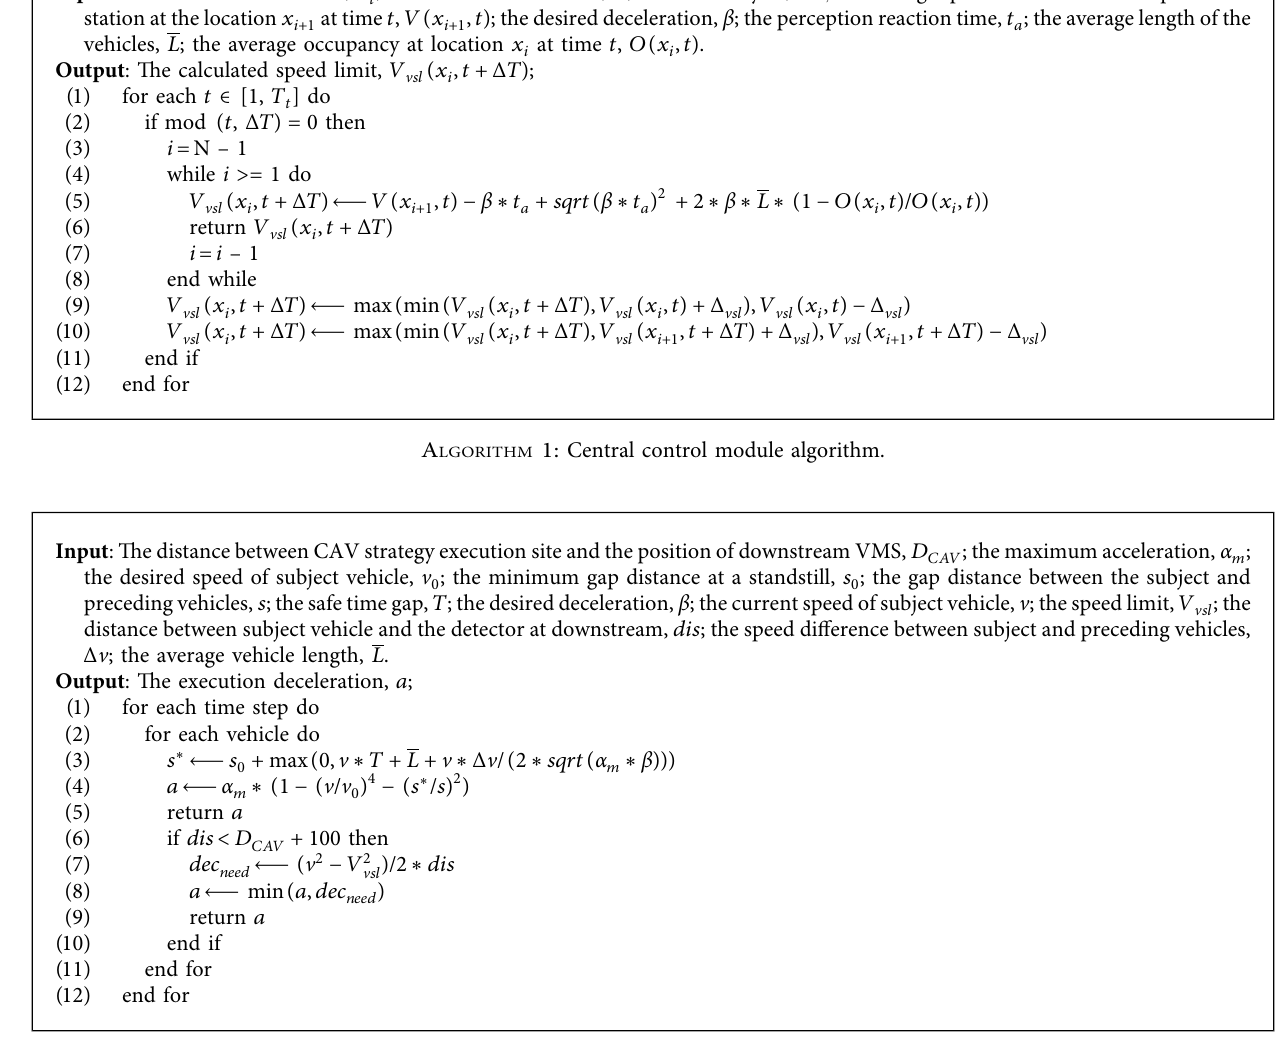
A LGORITHM 2: CAV on-board control module